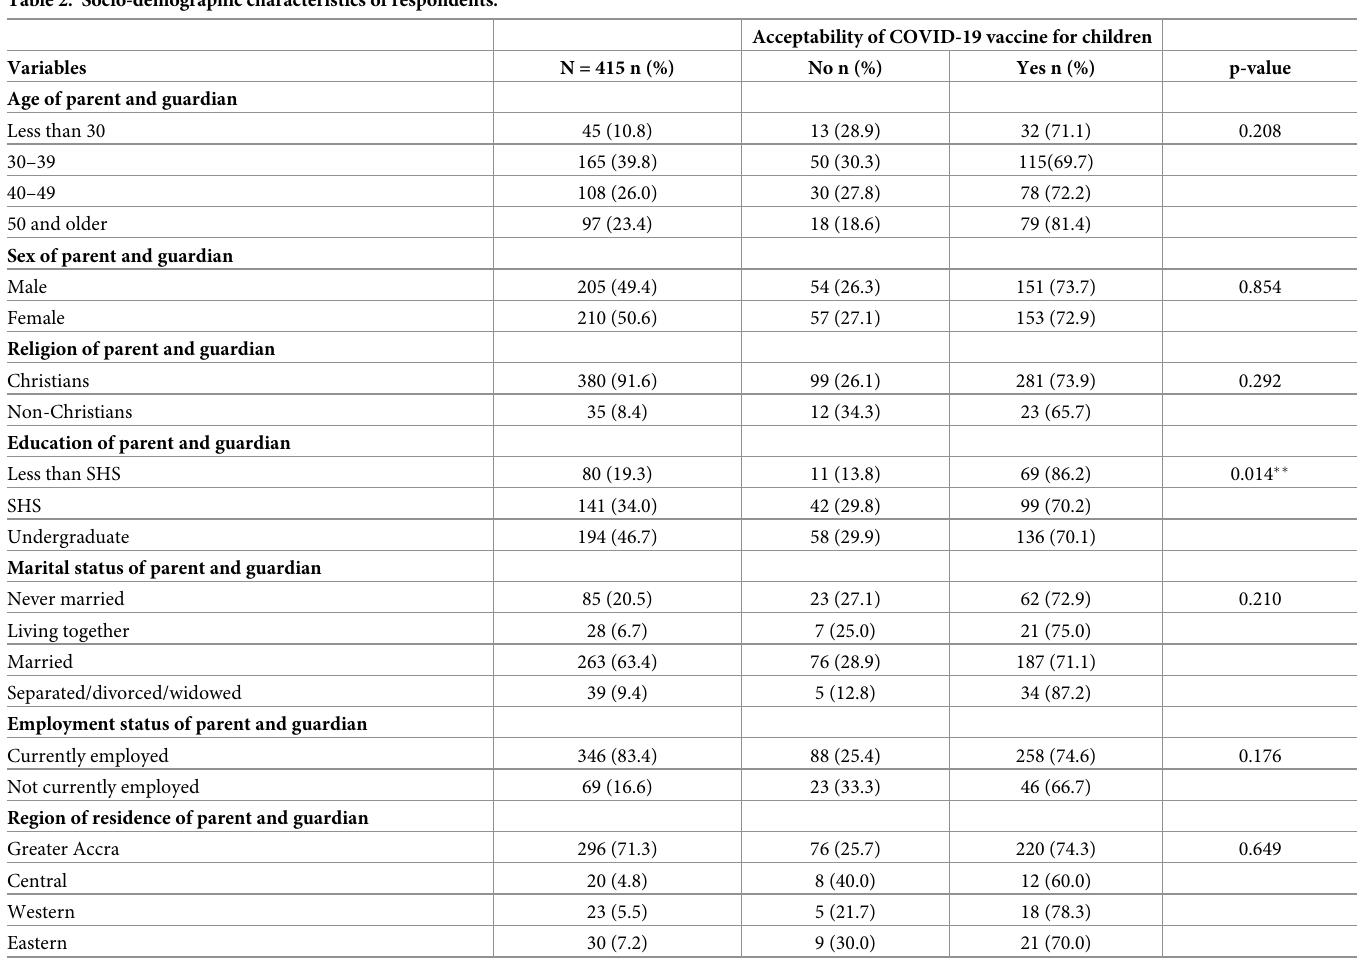
Table 2. Socio-demographic characteristics of